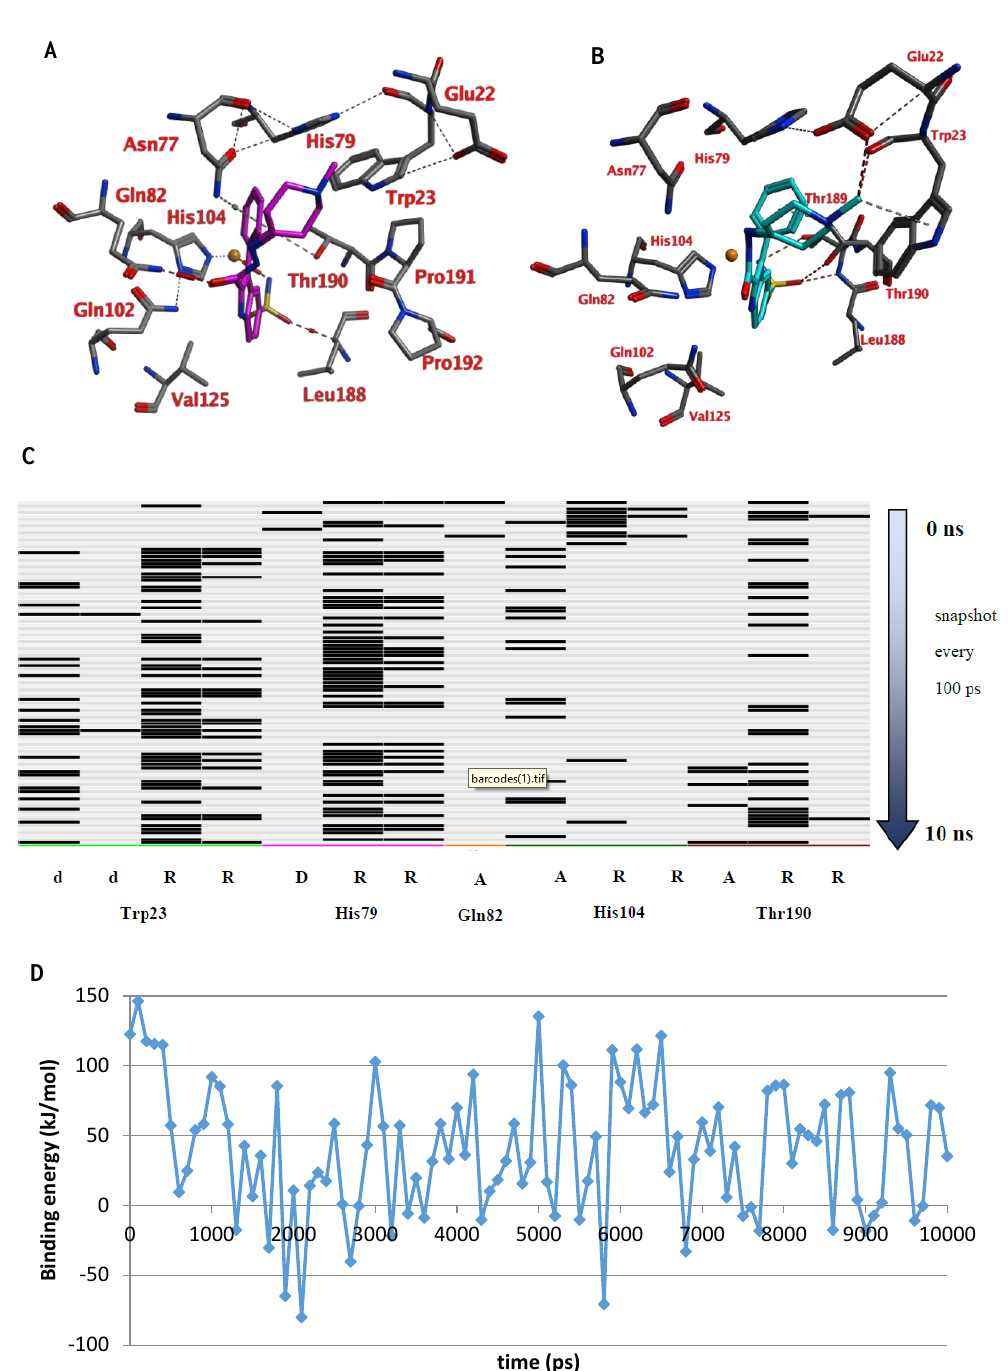
Figure 4. ( A ) The VcCA-23 structure obtained from docking (t = 0 ns). ( B ) The VcCA-23 model after a 10 ns MD simulation. ( C ) The protein–ligand interaction fingerprint (PLIF) showing the interaction of 23 with the VcCA binding pocket residues during the simulation as barcodes (a black line indicating the presence of the interaction at snapshot). ( D ) The binding energy (kJ / mol) between 23 and VcCA. Hydrogen bonds are indicated in red dashed lines. H–arene interactions are indicated in yellow dashed lines. “A” indicates sidechain acceptor interactions, “a” indicates backbone acceptor interactions, “D” indicates side chain donor interactions, and “R” indicates H–arene interactions. Two interactions of the same type per residue (for example “A” for Gln102) indicates that multiple interactions of the specified type between ligand and residue are formed. The arrow indicates the sequence of snapshots of every 100 ps.